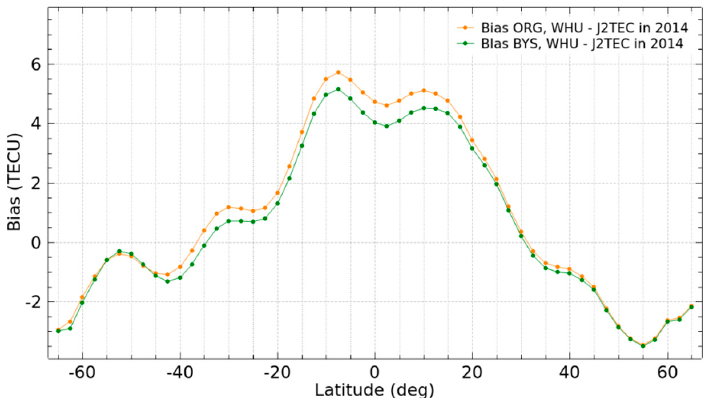
Figure 14. RMS values of differences between IGS GIMs or IAAC products and J2TEC in 2014.